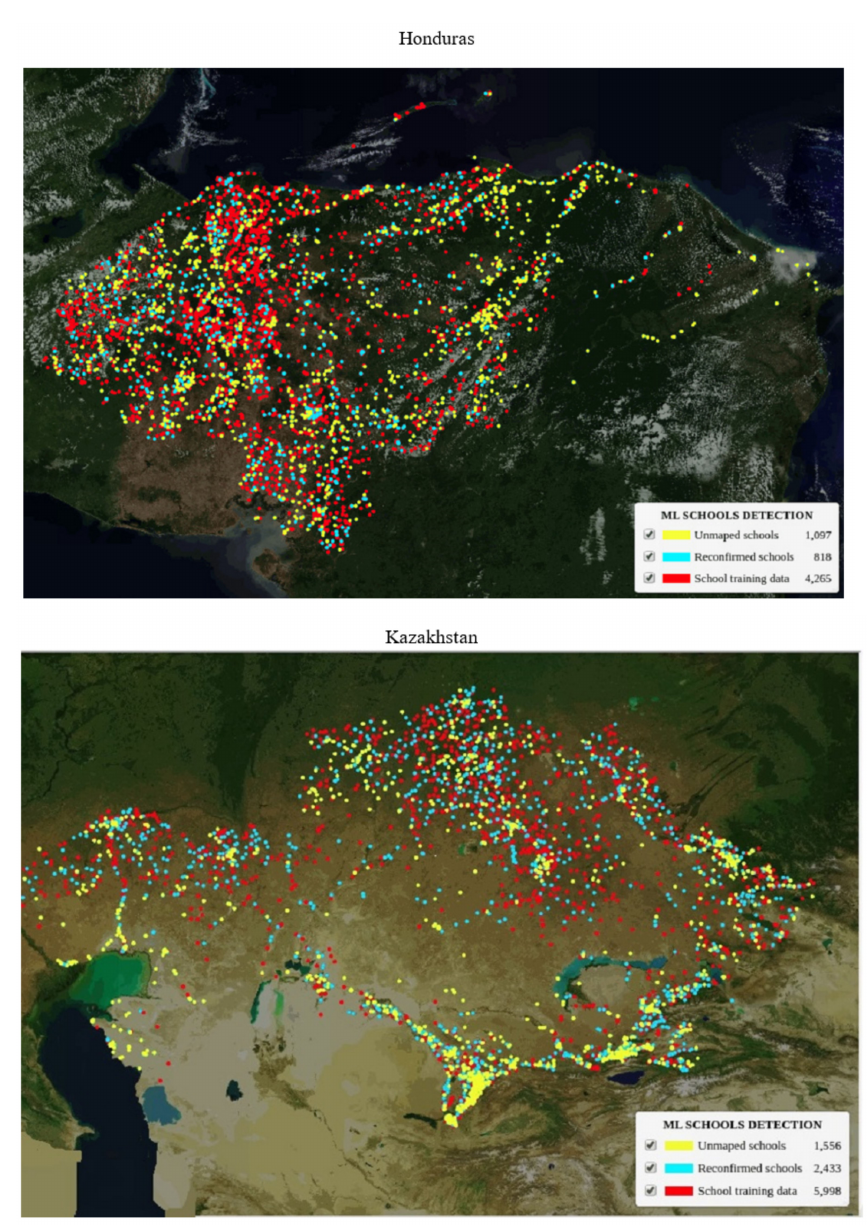
Figure 12. Map showing AI-discovered schools in Honduras and Kazakhstan.